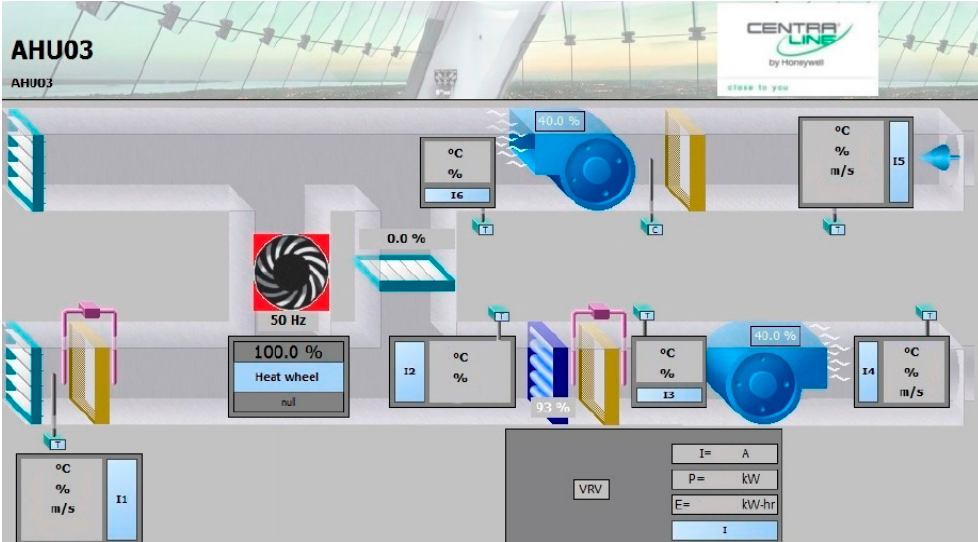
Figure 3. The AHU schematic in the building management system (BMS).